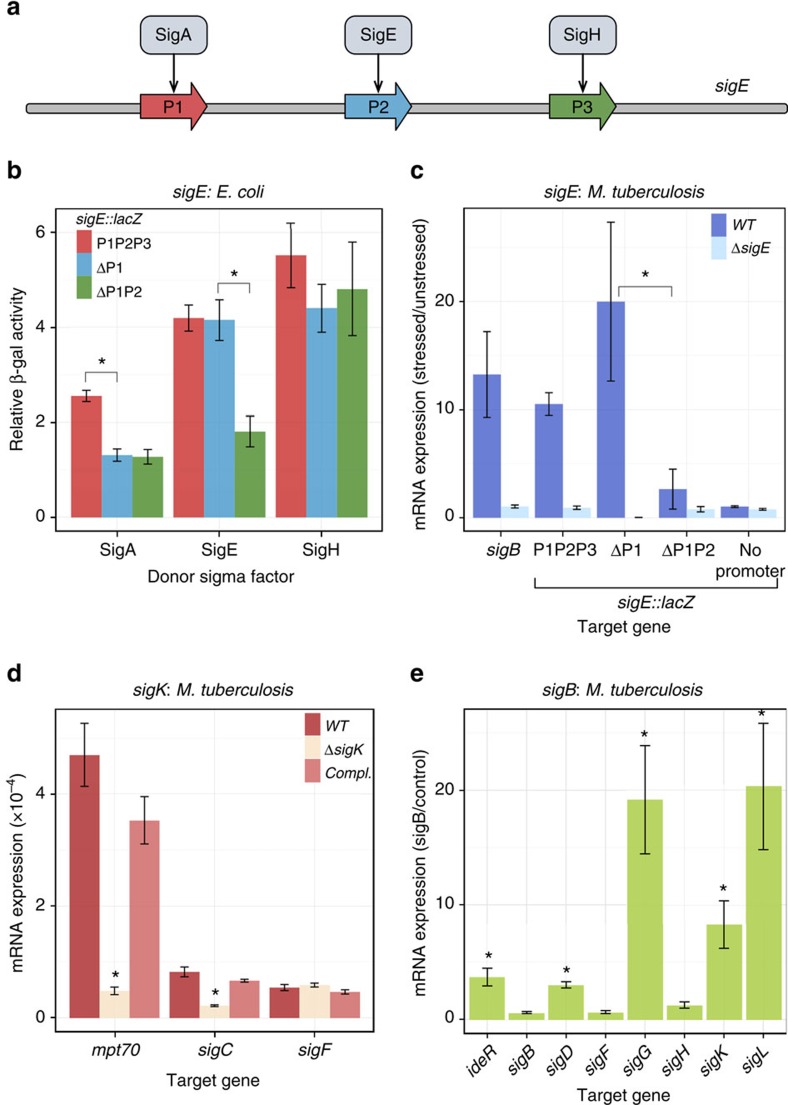
Experimental validation of selected links in
M. tuberculosis.(a) Schematic representation of the sigE promoter region. The three promoters upstream of sigE23 are recognized by SigA, SigE and SigH, respectively (this work and ref. 22). A search for consensus binding sites for SigA, SigE and SigH in the nucleotide sequences present in each promoter::lacZ fusion found no matches for SigA and SigE; instead, a match for SigH was found at the appropriate location upstream of the P3 transcription start site. (b) Effects of sigE promoter deletions on reporter β-galactosidase activity in E. coli. sigE::lacZ target plasmid and promoter-deletion derivatives were tested in cells containing sigma donor plasmids or a control plasmid (empty vector), as indicated. Relative beta-galactosidase activity was calculated as in the Fig. 2 legend. In this and the next panel, P1P2P3, native promoter configuration; ΔP1, deletion of P1; ΔP1P2, deletion of P1 and P2. (c) Effects of sigE promoter deletions on sigE::lacZ expression in M. tuberculosis. Mid-log-phase cultures of wild type and sigE deletion mutant of M. tuberculosis H37Rv containing a sigE::lacZ-carrying plasmid and promoter-deletion derivatives were treated with 0.03% SDS for 60 min. In this and subsequent panels, cells were collected, RNA isolated, and transcripts enumerated and normalized to 16S rRNA. mRNA levels were normalized relative to unstressed controls. No promoter=empty vector control. (d) Effect of sigK deletion on selected gene expression in M. tuberculosis. Mid-log-phase cultures of M. tuberculosis H37Rv, a sigK deletion mutant, and a complemented strain were used for transcript enumeration. (e) Effect of sigB induction on selected gene expression in M. tuberculosis. Mid-log-phase cultures of M. tuberculosis H37Rv containing an anhydrotetracycline (ATC)-inducible copy of sigB or a control (empty vector) construct were treated with 1.6 μg ml−1 ATC for 24 h and used for transcript enumeration. mRNA levels were normalized to empty-vector control. Data in panels b–e are presented as mean values (±s.e.m.) from triplicate experiments. Asterisk marks denote significance of the comparisons indicated (P<0.05 in one-sided t-test, and fold change >1.5).